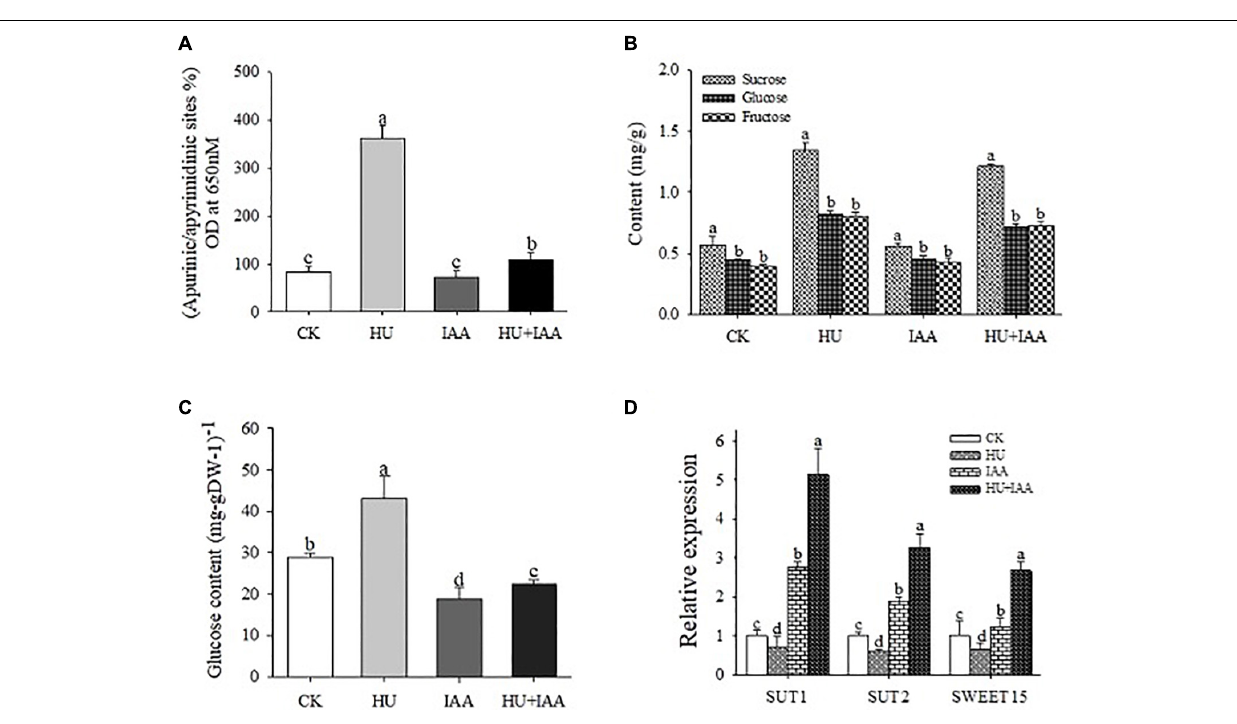
FIGURE 4 | DNA damage in rice plants treated with IAA, HU, and their combination. (A) Quantification of apurine/apyrimidine (AP) sites from the plants treated with HU, IAA, and their combination. (B) Sugar contents were analyzed using HPLC analysis. (C) Glucose contents. (D) The transcript level of starch and sucrose transporter genes ( SUT1, SUT2 , and SWEET15 ). Different letters indicate significant differences between treatments, tested by one-way ANOVA followed by Fisher’s test ( n = 3, p < 0.05). CK, Control; HU, Hydroxyurea; IAA, indole-3-acetic